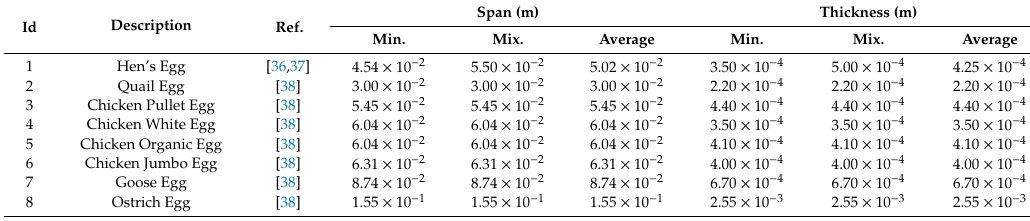
Table A10. Dimensions of the avian egg thin